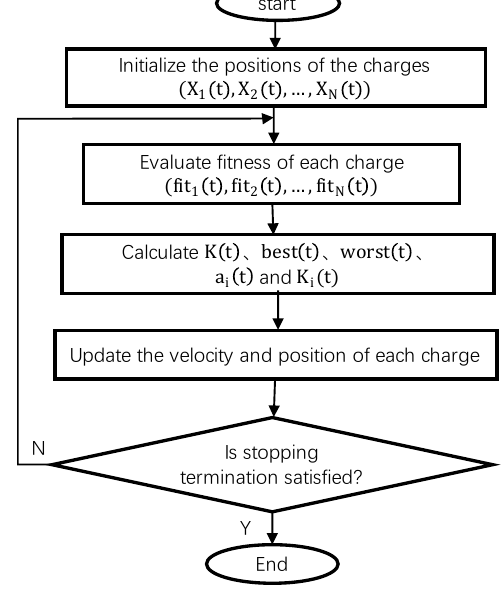
Figure 9. Flow chart of AEFA.